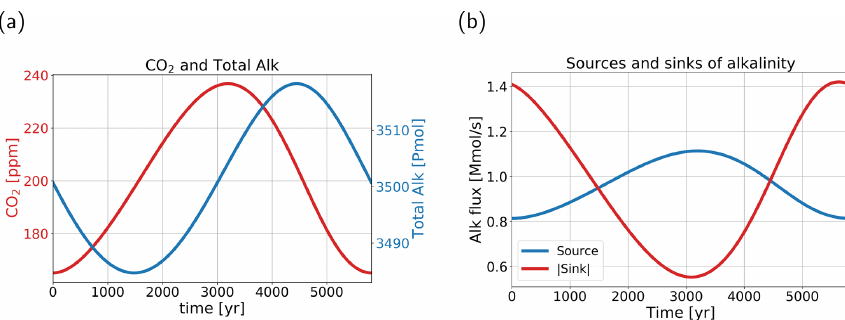
Figure 7. (a) Atmospheric p CO 2 (red, left y axis) in parts per million, and total alkalinity (blue, right y axis) in the ocean in petamoles for one oscillation. Total alkalinity lags p CO 2 by approximately a quarter period. (b) The source (blue) and the absolute value of the sink (red) of alkalinity in the ocean. The source represents river influx, and the sink represents the sediment outflux. When the lines cross, i.e., around 1500 and 4400 years, total alkalinity in (a) has a minimum and a maximum,